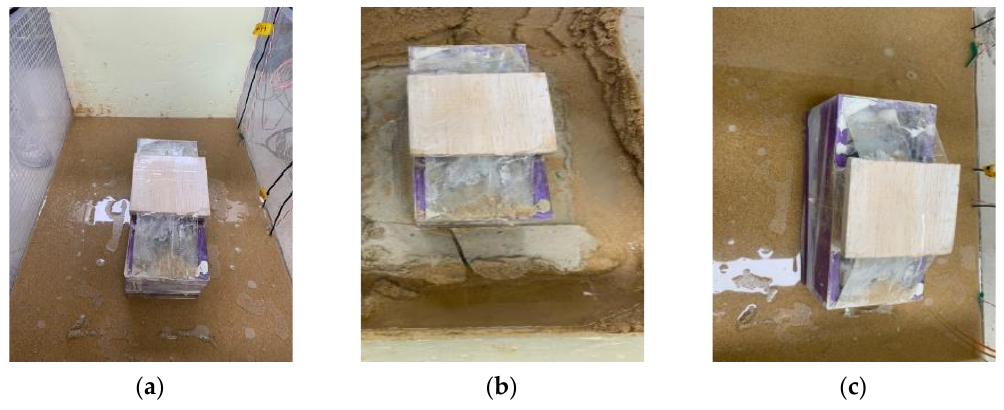
Figure 8. Grouting mixing ratio of 0.40 and separation distance of 0 cm: ( a ) Plane View ( b ) Crack of Grouting ( c ) Side View.